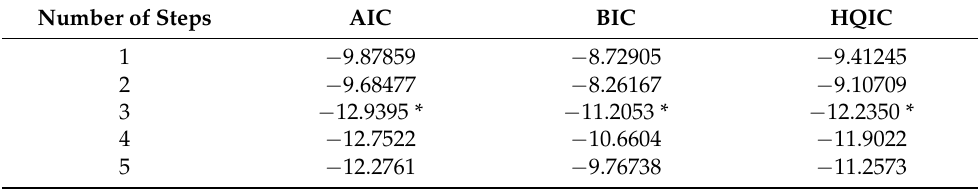
Table 4. Determination of optimal lag period.